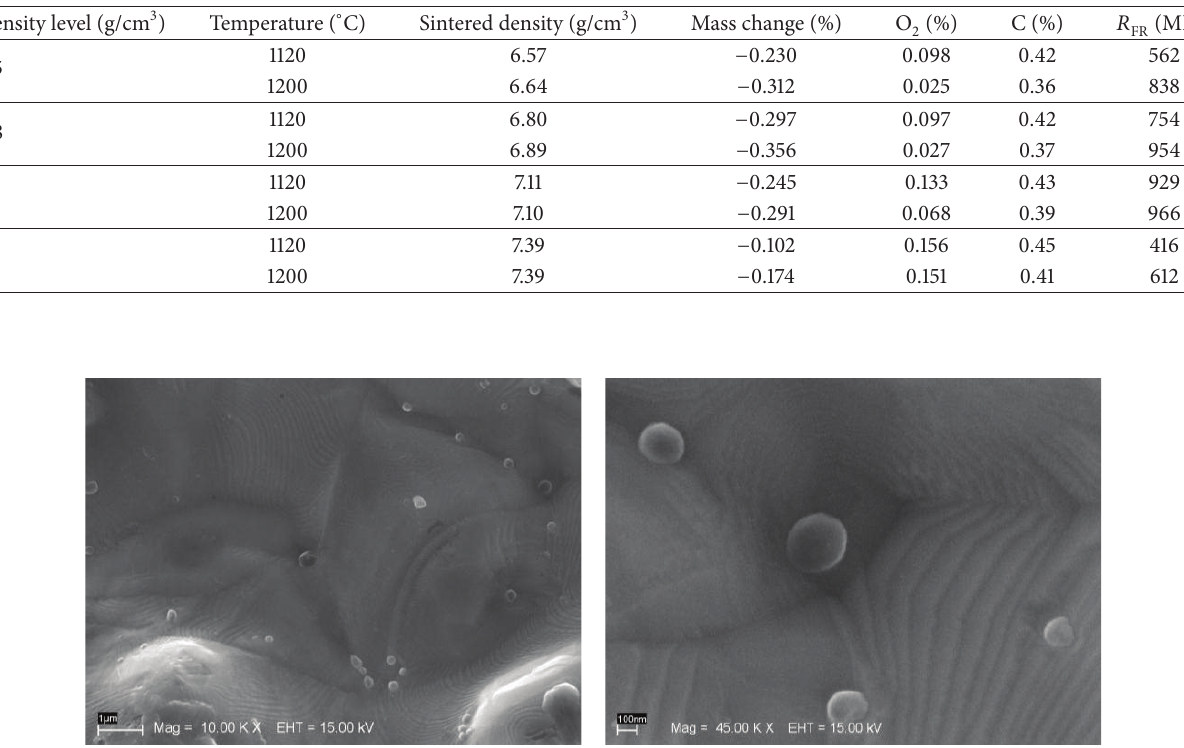
Table 4: Mass changes and oxygen and carbon contents in the AstCrM + 0.5% C material isothermal sintered at 1120 and 1200 ∘ C for 30min in relation to density.